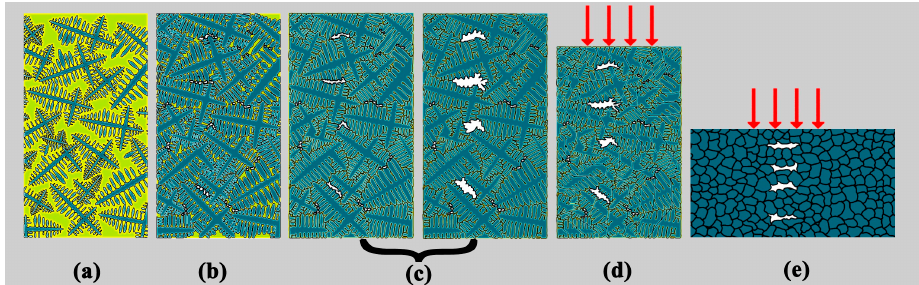
Figure 10. Schematic evolution of shrinkage porosity defects when deformed after completely solidified condition (1320 °C) in the study (The white regions in ( b – e ) represent shrinkage porosity, the yellow regions in ( a – c ) represent liquid).